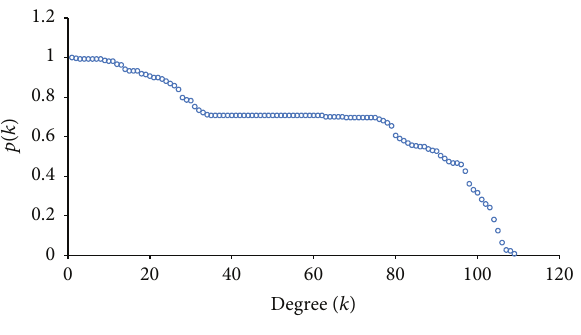
Figure 2: Degree distribution.